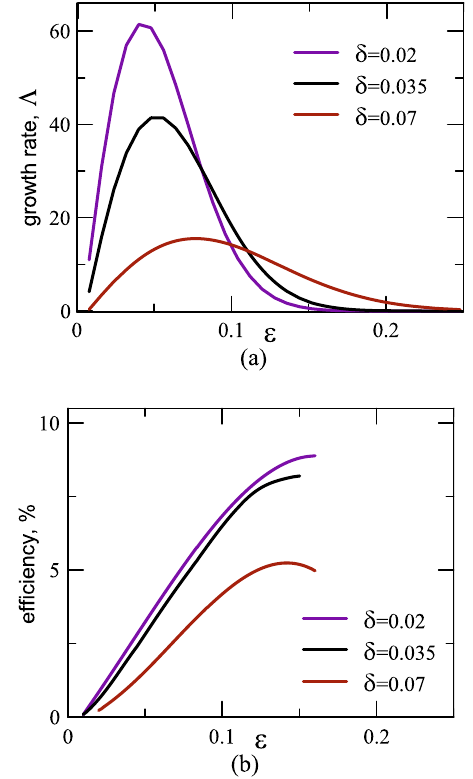
FIG. 4. Dependence of (a) spatial growth rate Λ and (b) the electron efficiency η on the shift ε between the center of the pump wave spectrum and the center of the electron distribution function for a fixed half-width of pump spectrum σ ¼ 0 . 07 but different values of electron energy dispersion δ .